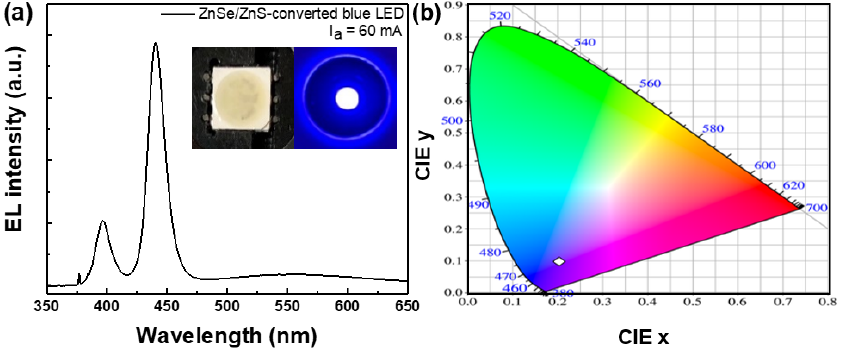
Figure 5. ( a ) EL spectra of the ZnSe/ZnS-converted blue LED at 60 mA and ( b ) CIE color coordinates of the ZnSe/ZnS-converted blue LED. The inset in ( a ) shows photographs of the ZnSe/ZnS-converted blue LED without (left) and with (right) applied current. In addition to fabricating the ZnSe/ZnS C/S QD-converted blue LED, ZnSe/ZnS C/S QD-converted white LEDs were also fabricated. White light can be generated by combining blue-emitting ZnSe/ZnS C/S QDs with yellow-emitting QDs. We synthesized yellow-emitting ZCIS/ZnS C/S QDs by referring to the previous method with a slight modification [32]. As shown in Figure 6, the ZCIS/ZnS C/S QDs exhibited an absorption band in the blue spectral region and a broad PL band under 450 nm excitation. The ZCIS/ZnS C/S QDs showed a broad PL band peaking at 565 nm with a wide FWHM of 115.5 nm, resulting in yellow luminescence. The PL QY of the yellow-light-emitting ZCIS/ZnS C/S QDs was measured at 83%. The absorption band of the ZCIS/ZnS C/S QDs was well matched with the emission band of the ZnSe/ZnS C/S QDs. Thus, a combination of ZnSe/ZnS C/S QDs and ZCIS/ZnS C/S QDs can create white light.